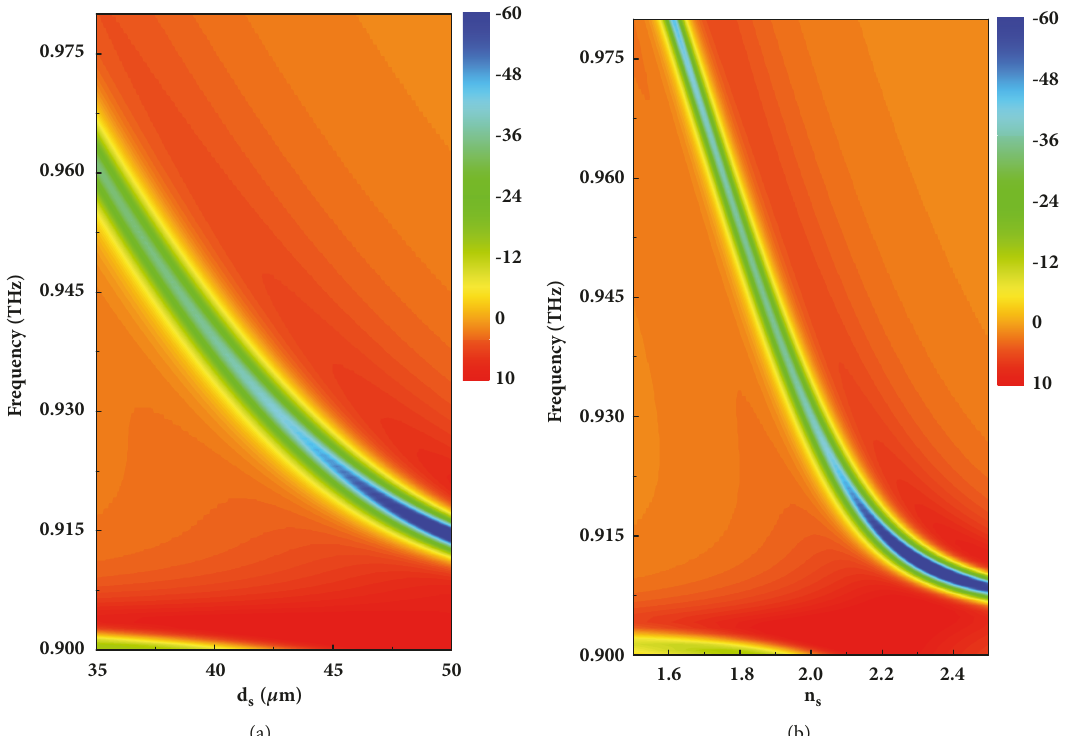
Figure 5: (a) Reflected group delay 𝜏 𝑟 as a function of frequency and 𝑑 𝑠 for the graphene-1DPC structure. (b) Reflected group delay 𝜏 𝑟 as a function of frequency and 𝜀 𝑠 for the graphene-1DPC structure. Other parameters are the same as